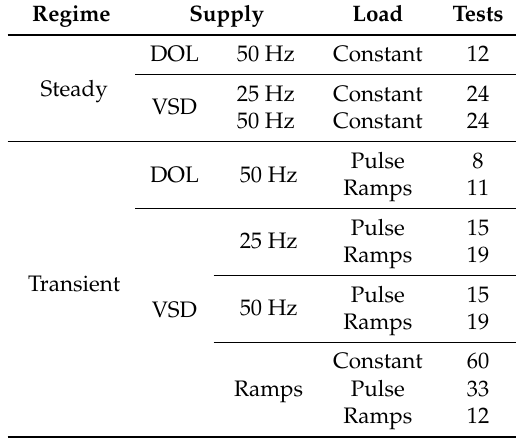
Table 2. Summary of the tests performed for the experimental